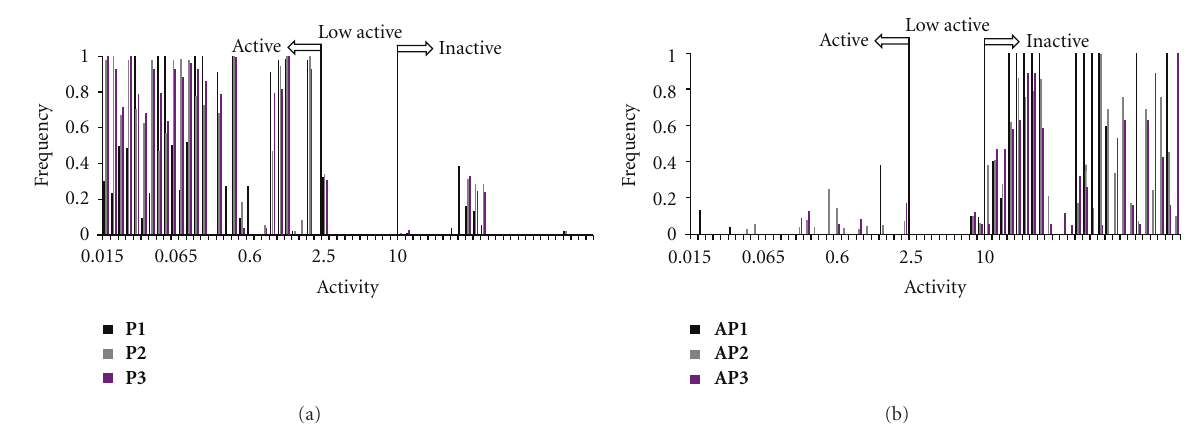
Figure 7: Frequency of the fragments’ occurrencies in the compounds studied: (a) for Pharmacophores P1 , P2, and P3 ; (b) for antipharmacophores AP1 , AP2, and AP3